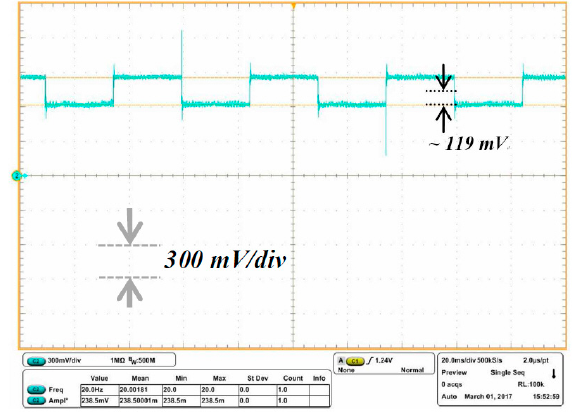
Figure 5. Output waveforms excited by 1.8 V self-test voltage with 20